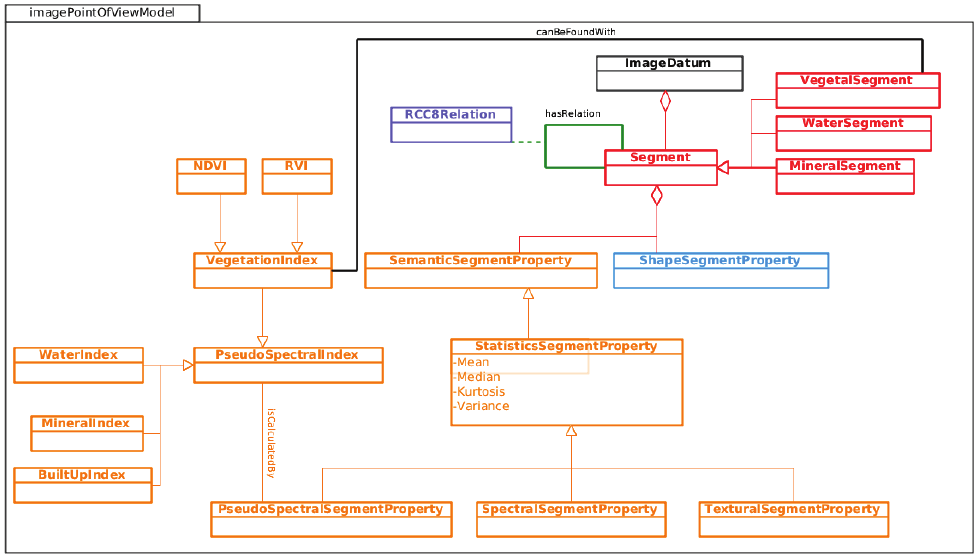
Figure 13: Image point-of-view